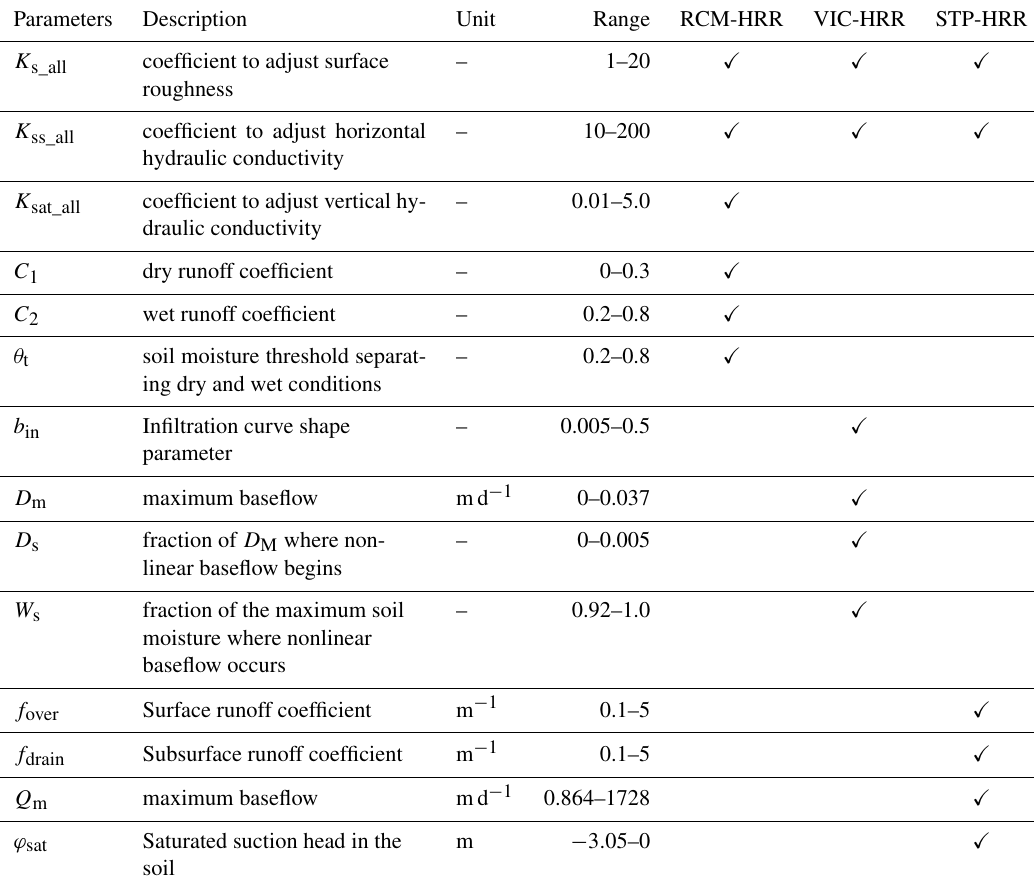
Table 1. Calibrated parameters for hydrologic